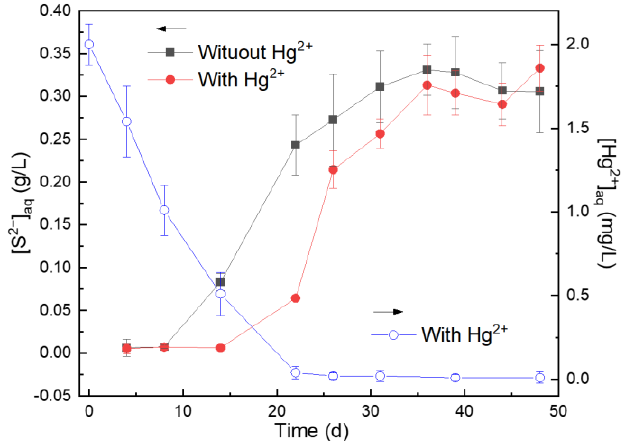
Figure 1. Changes in [S 2− ] aq and [Hg 2+ ] aq in the solution during microbially anaerobic S 0 reduction for the groups without and with Hg 2+ .